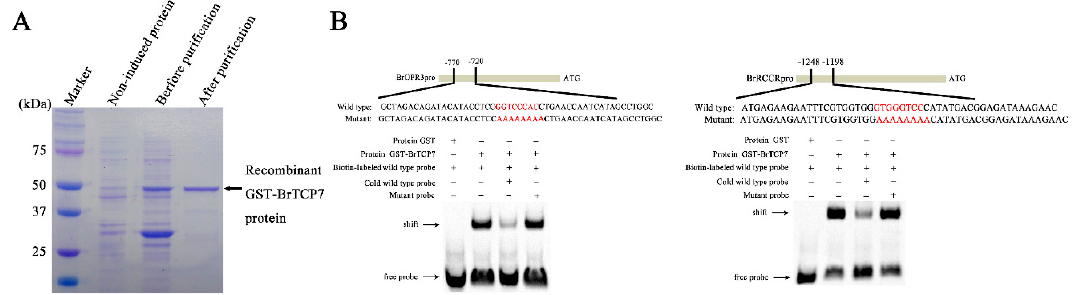
Figure 4. BrTCP7 directly binds to BrOPR3 and BrRCCR promoters. ( A ) SDS-PAGE gel stained with Coomassie brilliant blue demonstrating affinity purification of the recombinant glutathione-S-transferases (GST)-tagged BrTCP7 protein used for EMSA. Recombinant GST-BrTCP7 protein is indicated by the arrow. ( B ) EMSA showing the binding of BrTCP7 to the TCP binding site of the BrOPR3 or BrRCCR promoter. Purified GST-BrTCP7 protein was incubated with the biotin-labeled wild-type probe containing the TCP binding site, and the DNA–protein complexes were separated on native polyacrylamide gels. Sequences of both the wild-type and mutant probes are shown at the top of the image (wild-type and mutant TCP binding site are marked with red letters). The mutant probe was used to test binding specificity. Shifted bands, suggesting the formation of DNA–protein complexes, are indicated by arrows. − represents absence, + represents presence. Competition experiments were conducted by adding 250-fold molar excess of cold probe (unlabeled wild-type DNA fragment) or mutant probe.